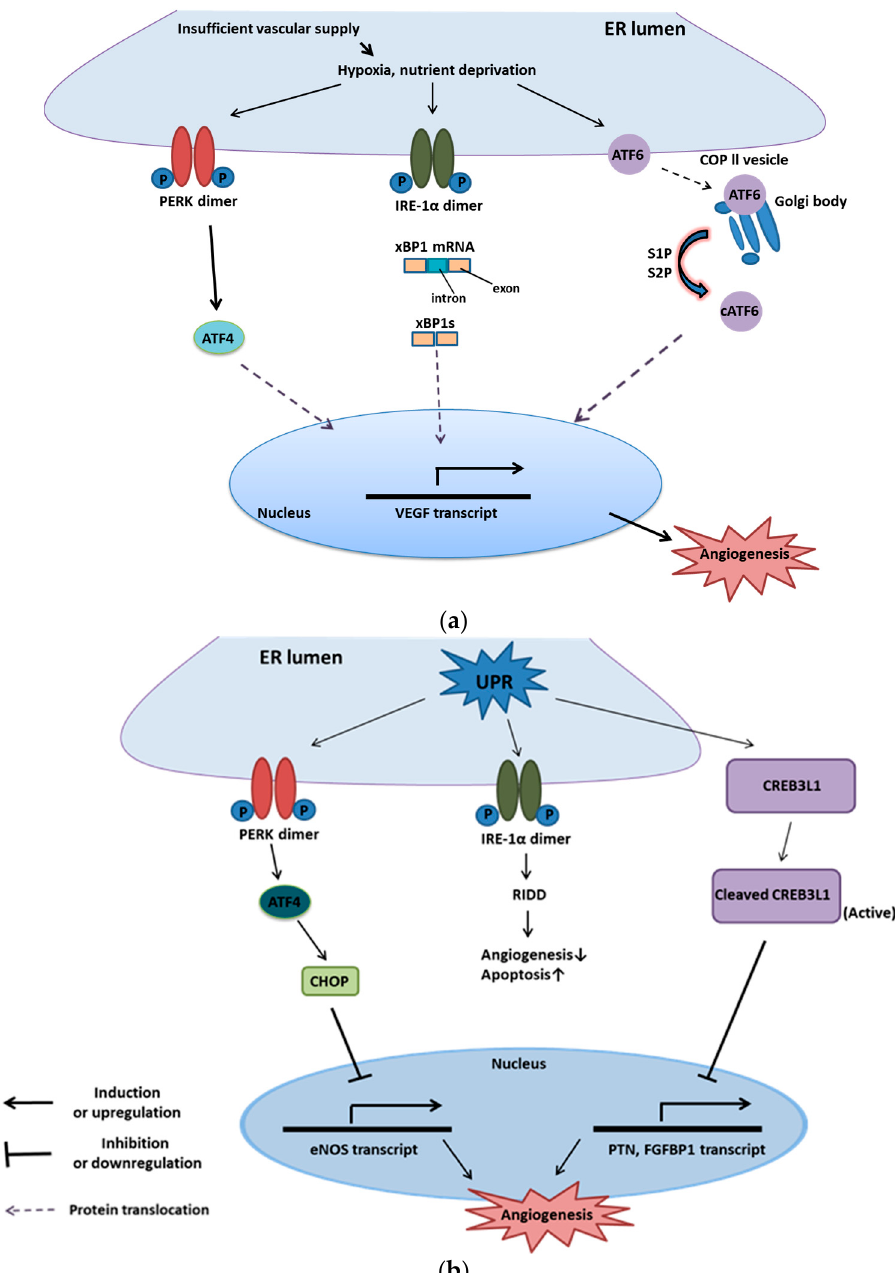
Figure 5. UPR and angiogenesis. [75] ( a ) UPR and pro-angiogenesis. Several low-stress adversities, such as hypoxia and nutrient deprivation, are accessible to activate three branches of UPR (IRE-1, PERK, and ATF6) on the ER membrane. Active IRE-1, PERK, and ATF6 can trigger transcription factors, namely XBP1s, ATF4, and cleaved ATF6, respectively, to upregulate VEGF expression, which leads to endothelial cell survival, proliferation and migration for angiogenesis; ( b ) UPR and anti-angiogenesis. Severe hypoxia and nutrient deprivation stimulate UPR to activate PERK on the ER membrane. Activated PERK can induce ATF4, a transcription factor, to upregulate the expression of CHOP. CHOP also serves as a transcription factor and is accessible to bind with pro-angiogenic mRNA, such as eNOS, to inhibit angiogenesis. Furthermore, high-intensity ER stresses trigger UPR and stimulate CRE3BL1 to be cleaved by RIP (regulated intermembrane proteolysis) to generate active CRE3BL1. Then, the activated CRE3BL1 translocates to the nucleus and binds with pro-angiogenic mRNA, such as PTN (Pleiotrophin) and FGFBP1 (Fibroblast growth factor-binding protein1), to block angiogenesis.